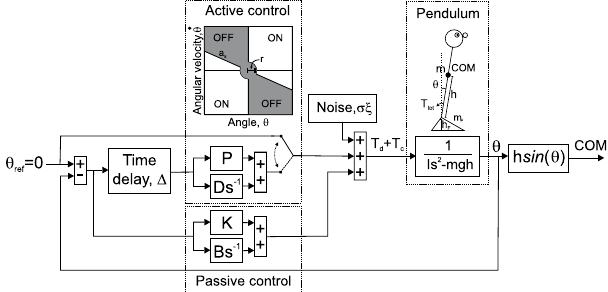
Figure 1. Sway model 21 . Human body is modelled as a rigid, weightless inverted pendulum with a point mass, m , at the height, h , of the body’s center-of-mass (com), rotating around a single link (ankle). The perturbations or noise, σ , due to gravitation and internal and external disturbances, such as blood circulation and respiration, cause the body to be unstable. Passive (stiffness K , damping B ) and active (stiffness P , damping D ) control (here proportional and derivative controllers) calculate a control torque, T c , that is needed to counteract the torques caused by disturbances and gravitation ( T d and T g ). Passive control describes continuous muscle tone, and active control –that acts with time delay, Δ ,– describes CNS action. Active control is ‘ON’ only when needed, according to the magnitude and direction of body angle, θ , and angular velocity, θ  . The level of control, C ON , models this amount or fraction of active torqueing. Finally, s is the Laplace transform variable. Five parameters were chosen for the inference: P , D , Δ , σ , and C ON . Please see explanations for rest of the parameters in Section Methods (The control